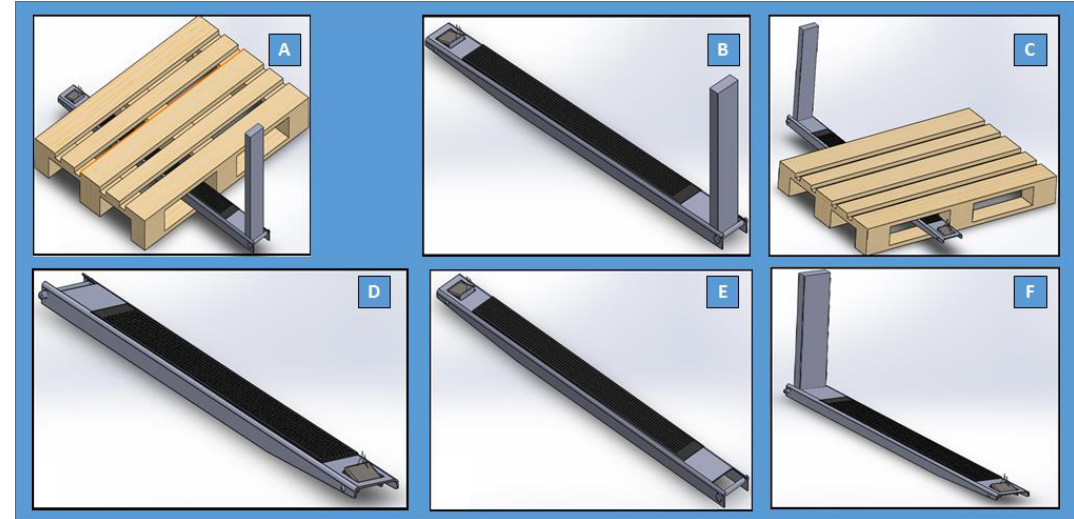
9 of 20 Figure 7. Position of the load on the fork carriage of the forklift: slip-off case; tipping case: l is the distance of the center of gravity of the load from the beginning of the fork; h is the height of the center of gravity of the load from the fork. Simulation calculations were performed using Matlab-Simulink, which was pre- sented at the International Conference on Computer Aided Engineering. After conference